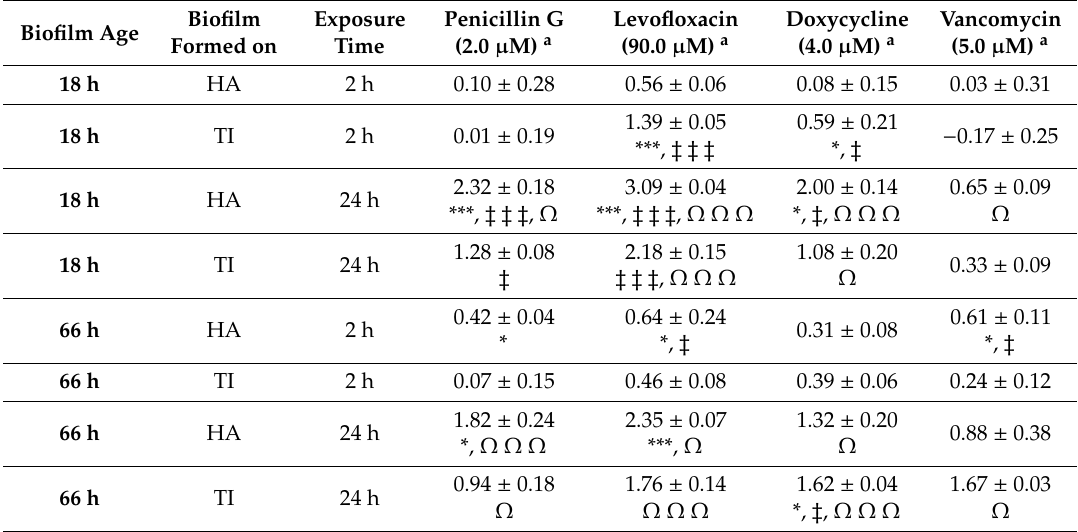
Table 3. The chemotolerance of S. aureus ATCC 25923 as quantified using the log reduction of viable counts. The 18-h- and 66-h-old biofilms were formed on hydroxyapatite (HA) and titanium (TI), and exposed to penicillin G, levofloxacin, doxycycline and vancomycin.